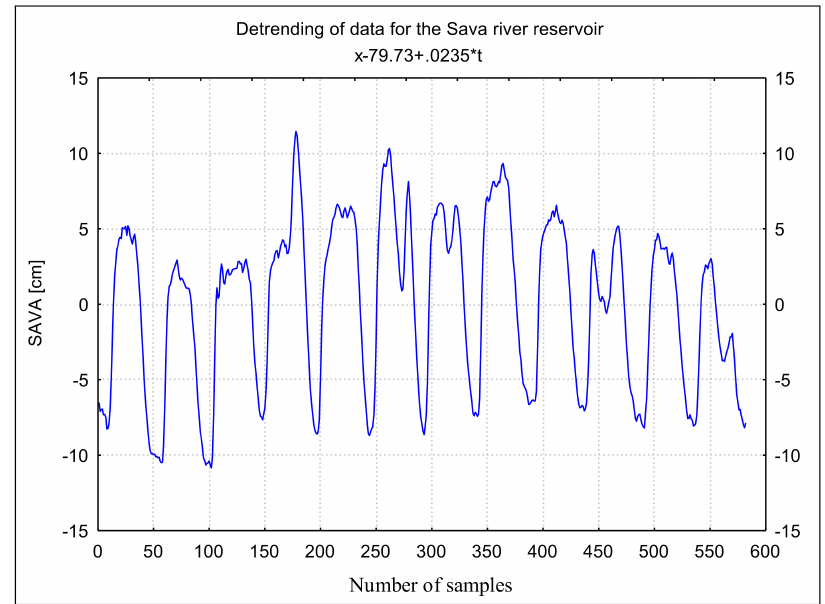
Figure 4. Detrended water level oscillation of the Sava in centimetres.